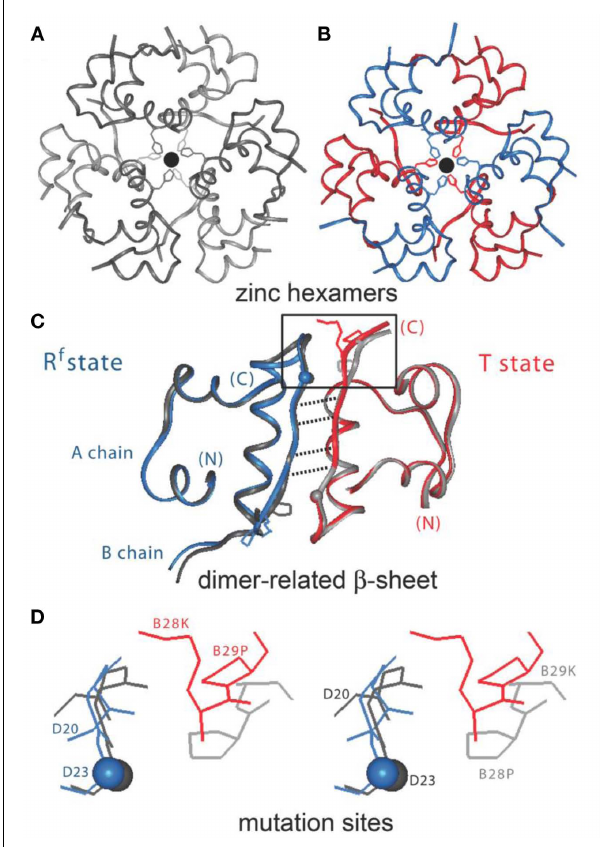
FIGURE 2 | Design of insulin lispro . (A,B) Ribbon models of the wild-type zinc insulin hexamer (A) and KP-insulin (B) .The hexamer type is in each caseT 3 R f .The A- and B-chains in (A) are shown in light and dark gray, 3 respectively; the A- and B-chains in (B) are shown in red and blue. In each hexamer the overlying positions of the axial zinc ions are shown as central black circles coordinated by the side chains of His B10 (three per metal-ion binding site). Respective Protein Databank accession codes are 1TRZ (wild-type) and 1LPH (KP-insulin; Ciszak et al., 1995). (C) Structure of componentTR f insulin dimer in the wild-type hexamer (light and dark gray) and variant hexamer (red and blue).The structures were aligned according to the main-chain atoms of residues B3–B28 and A2–A21.T- and R f -protomers are shown at right and left, respectively, in an orientation that highlights the dimer-related β -sheet (residues B24–B28) and its four inter-molecular hydrogen bonds (dotted lines; Baker et al., 1988). Boxed region contains sites of substitution in KP-insulin. (D) Enlargement of boxed region in (C) .The KP substitutions are associated with lengthening of the inter-molecular hydrogen bonds and subtle repositioning of residues B28–B30 (Ciszak et al., 1995). Respective Gly B23 C α atoms in corresponding R f protomers are indicated by gray (wild-type) and blue (variant) spheres. In the wild-type hexamer electron density (accession code 1TRZ) was not well defined for the C γ , C δ , and N ε atoms of Lys B29